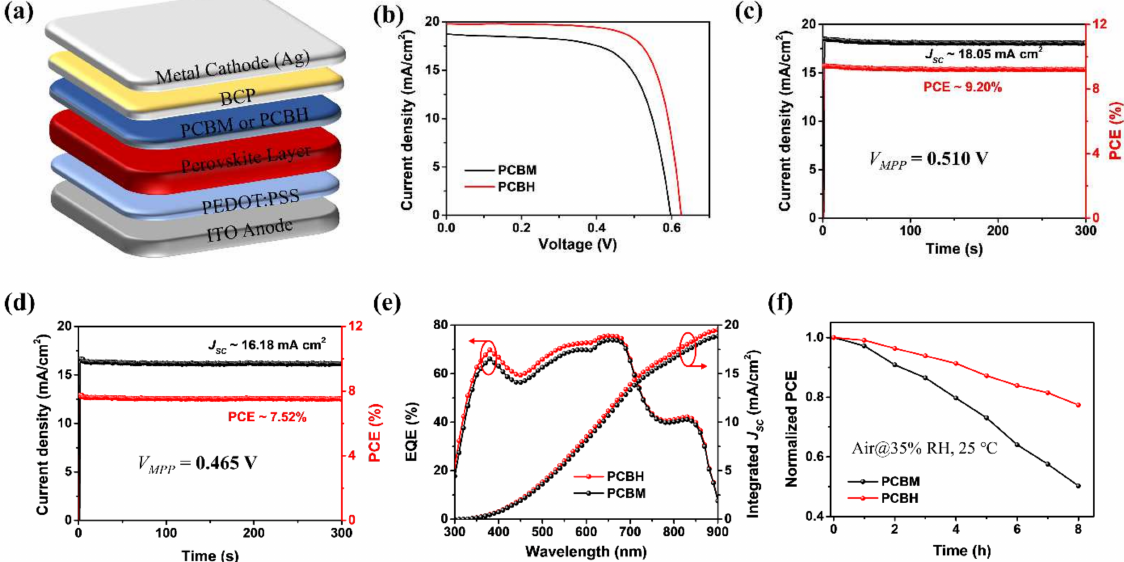
Figure 3. ( a ) Device architecture of the TPSCs. ( b ) The J – V curves of the best PCBH- and PCBM- based TPSCs. Maximal steady-state output for ( c ) PCBH- and ( d ) PCBM-based TPSCs and their corresponding power output. ( e ) The EQE and integrated current curves of the PCBH- and PCBM- based TPSCs. ( f ) The stability test of the PCBM- and PCBH-based